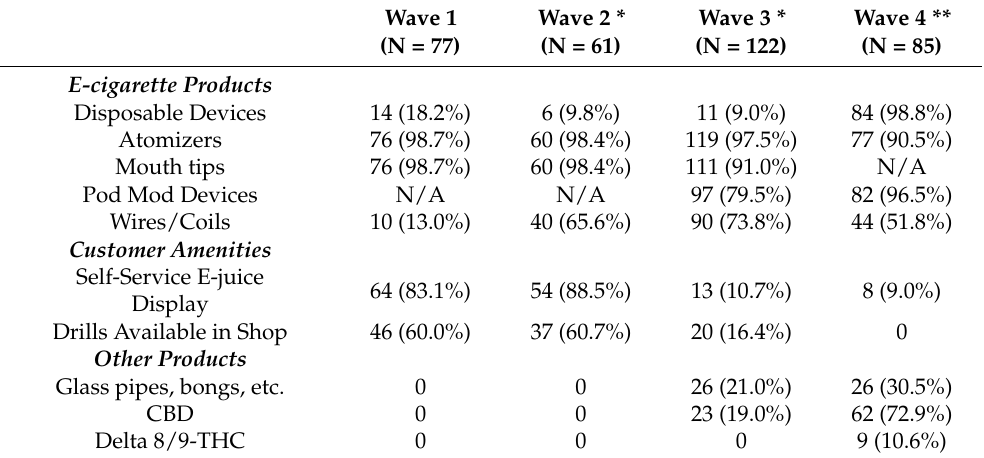
Table 1. Products Sold in Vape Shops by Year (A non-longitudinal sample of